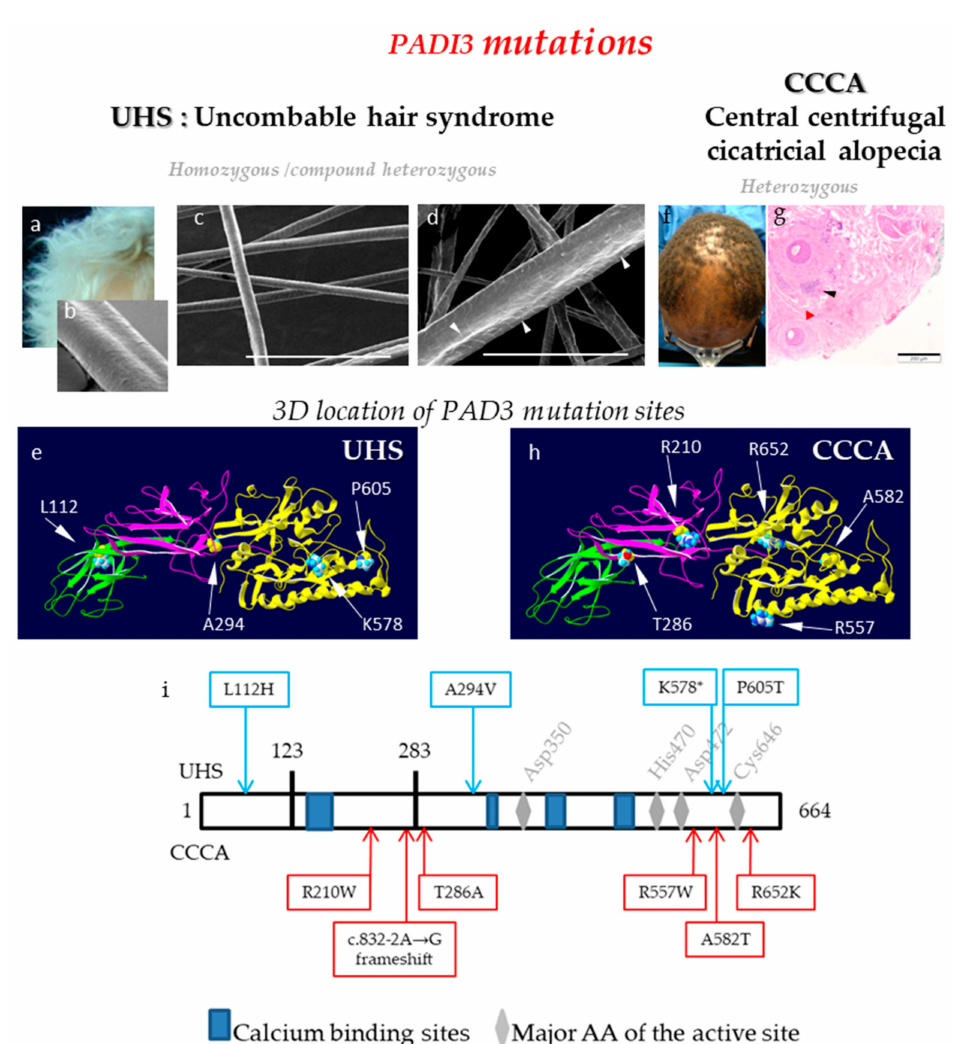
Figure 5. PADs and deimination in hair follicle disorders. ( a ) Illustration of the macroscopic hair phenotype of an UHS patient. (b-d) Representative scanning electron microscopy observations of the abnormal longitudinal UHS hair shape ( b ), hair follicles of Padi3 wild type mice; ( c ) and hair follicles of Padi 3 knockout mice ( d ). Bar = 150 µ m. White arrowheads point the abnormalities of the hair shape. ( e ) Localization of PAD3 amino-acids that are mutated in UHS patients. ( f and g ) Hair phenotype of a Central Centrifugal Cicatricial Alopecia (CCCA) patient and histological observation. Black and red arrowheads point to inflammatory infiltrate, and fibrosis, respectively. Bar = 200 µ m. ( h ) Localization of PAD3 amino-acids that are mutated in CCCA patients. ( i ) Position of the pathological mutations on a linear representation of PAD3. Mutations responsible for UHS (top) or CCCA (bottom). The in silico 3D model of PAD3 ( e , h ) was produced by similarity from the crystallographic data of PAD4 (PDB ID: 1WDA), as previously published